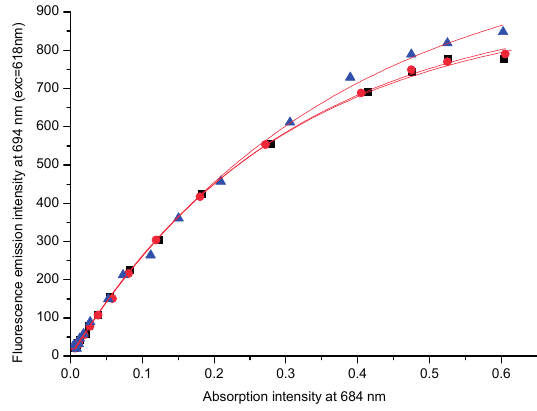
Figure 5. UV-vis absorption intensity at 684 nm and fluorescence emission intensity at 702 nm ( λ exc = 618 nm) under the same instrument conditions for compounds 10 (rac, ▲ ), ( 11 , S , ● ) and ( 12 , R , ■ ), for different concentrations in DMSO, with higher stock solution 5 μ mol·L − 1 .